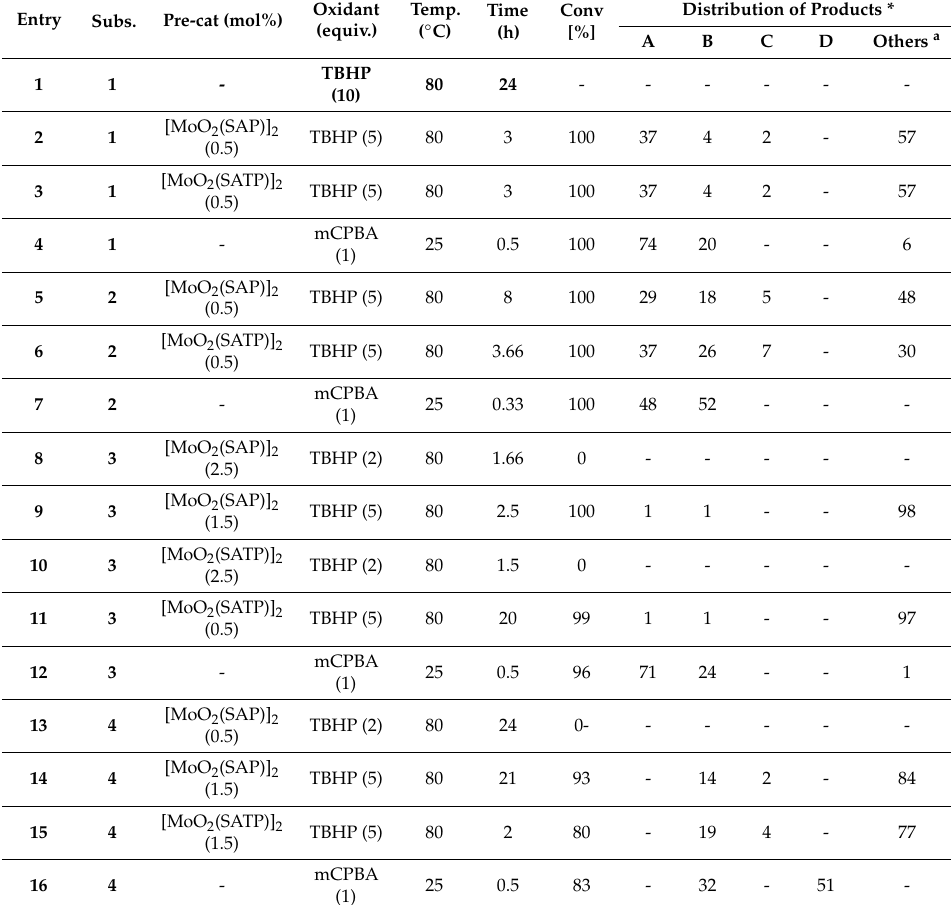
Table 1. Conversions and ratio of product for all reactions. Compounds A, B, C and D are shown in Figure 6.